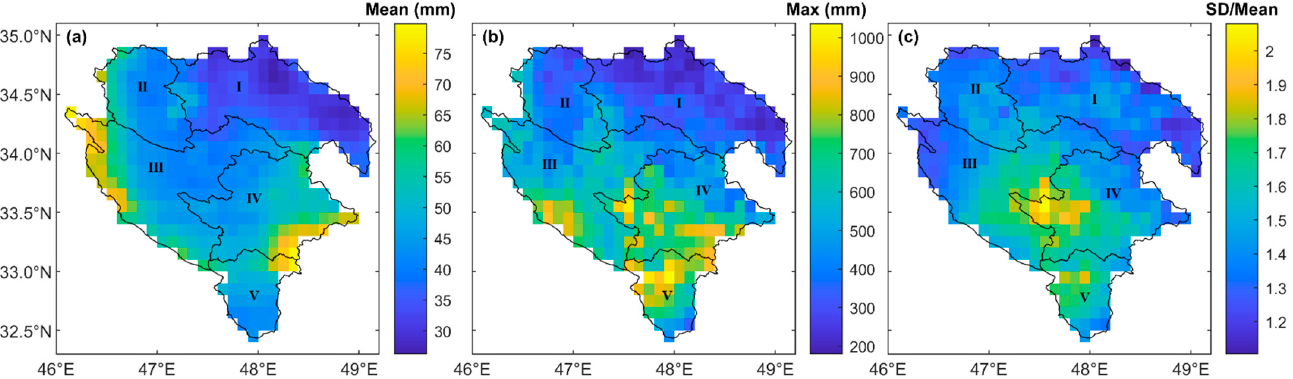
Figure 10. Grid-based mean ( a ), maximum ( b ), and coefficient of variation ( c ) of monthly precipitation from GPM-IMERG-Late over Gamasiab (I), Qarasu (II), Seymareh (I–III), Kashkan (IV), and the entire study area of KRB (I–V).